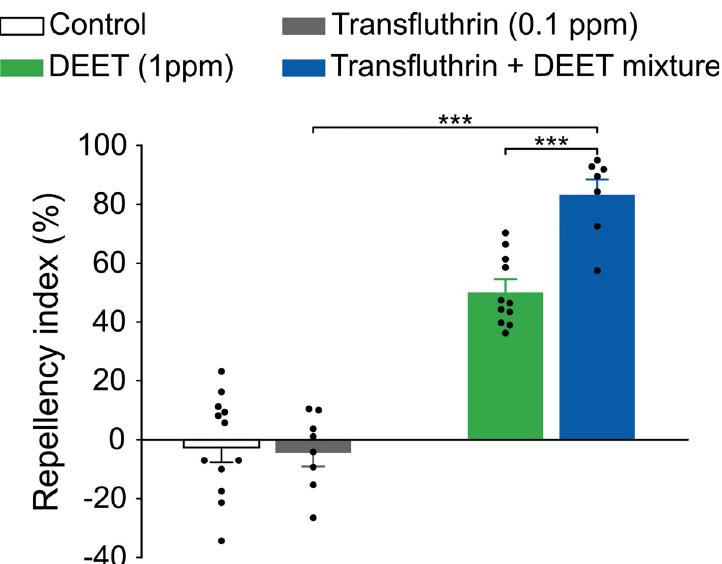
Fig 5. Transfluthrin potentiates the repellency by DEET in Rockefeller mosquitoes. Student’s t -test, for mixture vs transfluthrin: t = 12.82, df = 13, P < 0.001, for mixture vs DEET: t = 5.57, df = 16, P < 0.001, ��� P < 0.001; n values for: mixture = 7, transfluthrin = 8, DEET = 11, and control = 12. The control represents the baseline activity in response to the solvent. Data are presented as mean ± SEM, and dots over the bars represent individual replicate values.